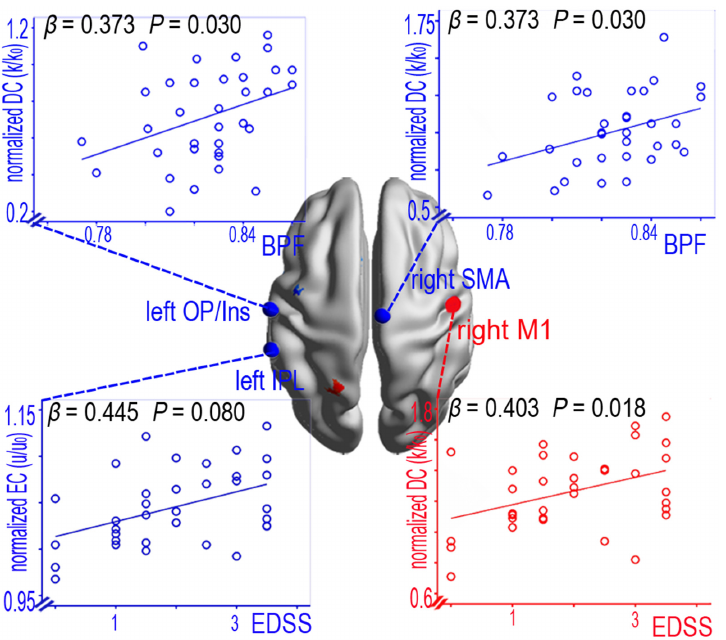
Fig 5. The correlations between the centrality (DC and EC) metrics within the entire SMN and the clinical variables in the remitting phase of RRMS